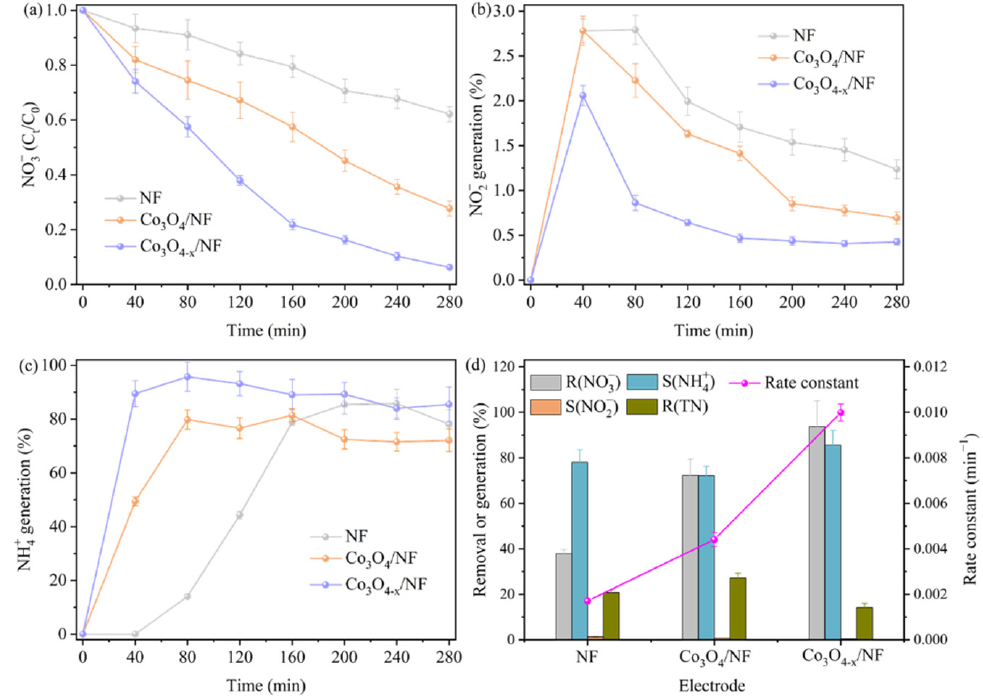
Figure 4. Reduction of NO 3 − ( a ), generation of NO 2 − ( b ) and NH 4 + ( c ), and TN removal and rate constant ( d ) for different cathodes. Electrolysis conditions: Cathodic potential = − 1.2 V (vs. Ag/AgCl), Initial NO 3 − concentration = 50 mg N L − 1 , Solution volume = 80 mL, pH = 7.0, Stirring rate = 600 rpm, Electrolysis time = 280 min.